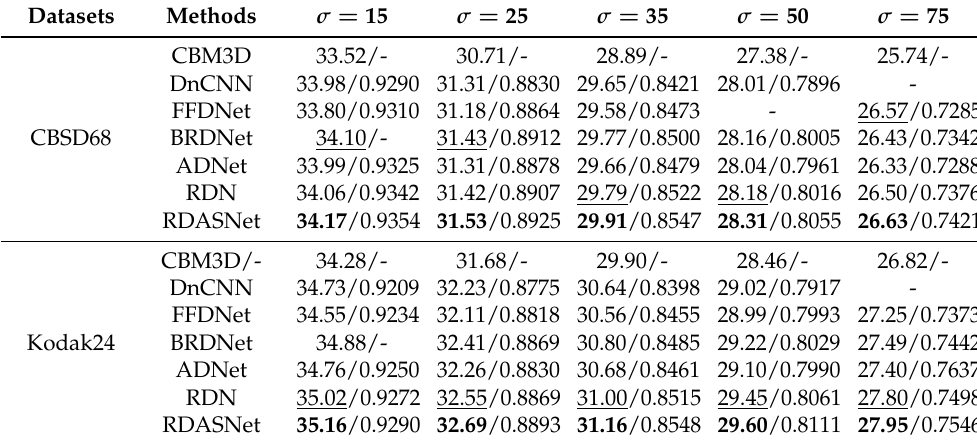
Figure 7. Denoising results of different methods on one image from Kodak24 with noise level σ = 35: ( a ) original image, ( b ) noisy image, ( c ) CBM3D/27.33 dB, ( d ) DnCNN/28.43 dB, ( e ) FFDNet/28.60 dB, ( f ) BRDNet/28.88 dB, ( g ) ADNet/28.68 dB, ( h ) RDN/28.94 dB, and ( i ) RDASNet/29.11 dB. Table 4. PSNR (dB) and SSIM of different methods on the CBSD68, Kodak24, and McMaster for different noise levels (i.e., 15, 25, 35, 50, and 75). The best PSNR two results are shown in bold and underlined,